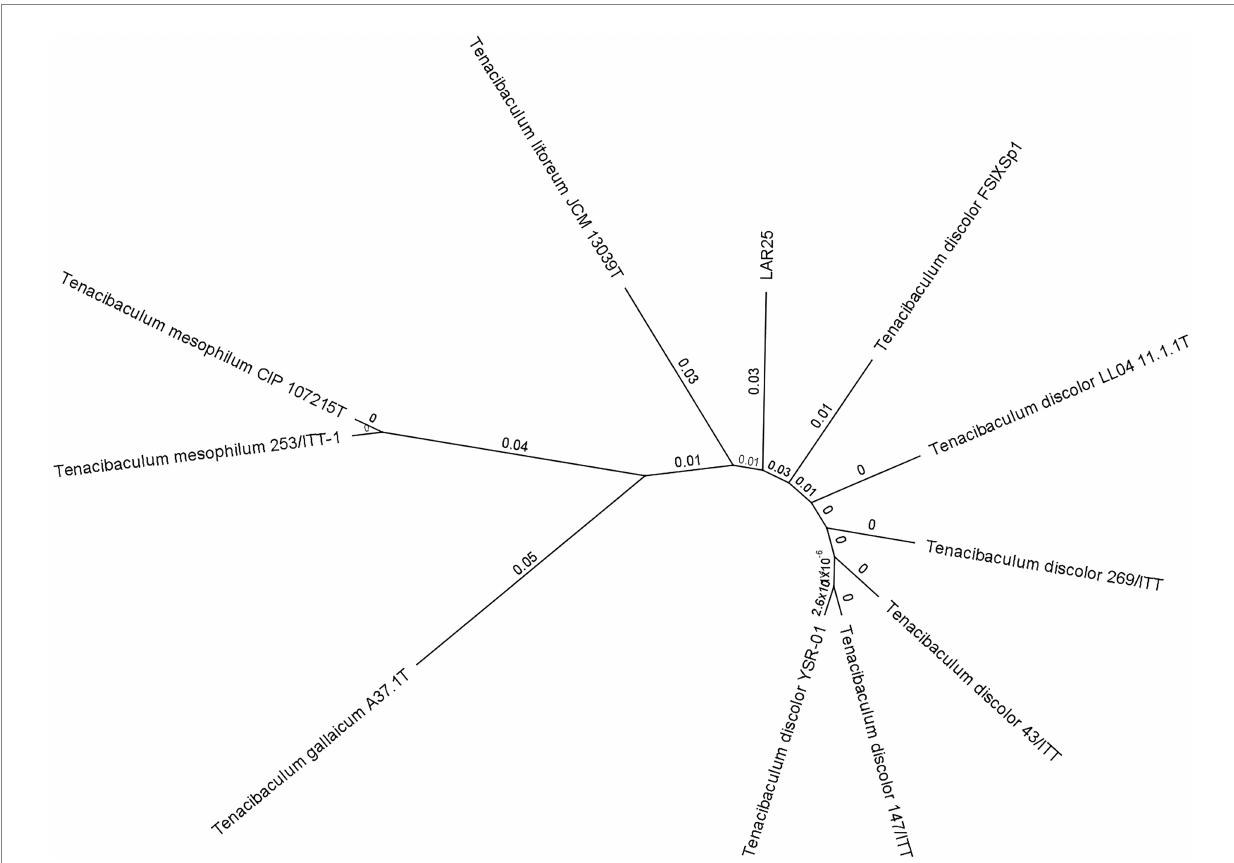
FIGURE 5 Phylogenetic relationships between Tenacibaculum strains based on neighbor joining (NJ)-multilocus sequence typing (MLST) analysis on concatenated sequences of atpA, dnaK, glyA, gyrB, infB, rlmN, tgt genes. Labels on branches indicate substitution per site